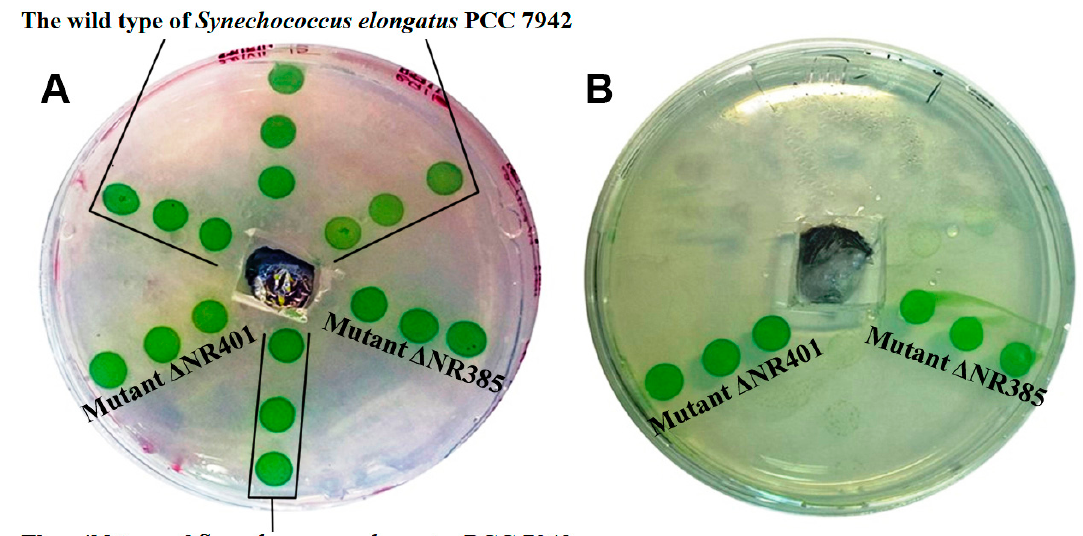
of mutants ∆ NR401 and ∆ NR385. ( A ) Control plate. The growth of the wild type and mutant cells is insertion of mutants Δ NR401 and Δ NR385. ( A ) Control plate. The growth of the wild type and similar. ( B ) 100 µ mol of 2-nononone was added. The growth of the wild type cells is inhibited. The mutants ∆ NR401 and ∆ NR385 demonstrated growth at the ketone presence.